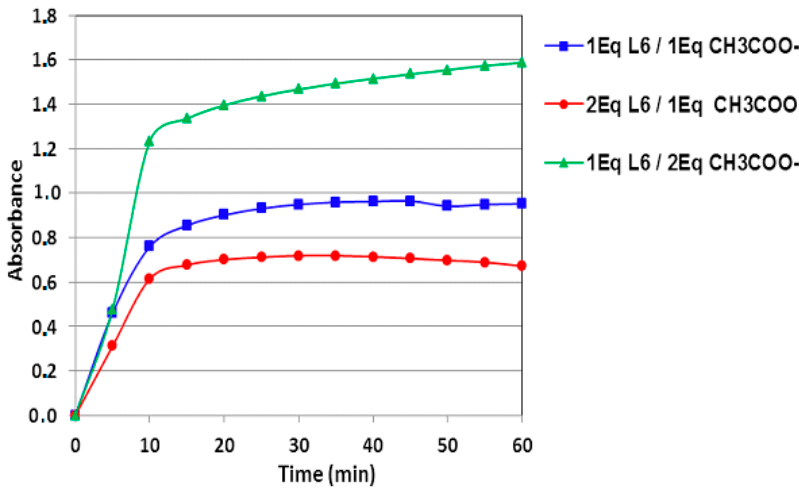
Figure 7. Catechol oxidation in methanol, in presence of formed L6 copper complexes with different concentrations. different